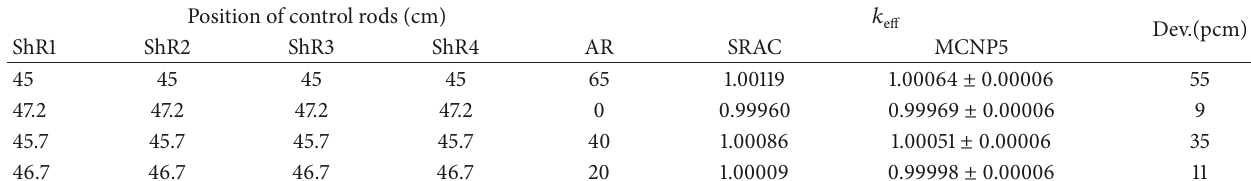
Table 3: Criticality calculations of the DNRR with four control rod banks.